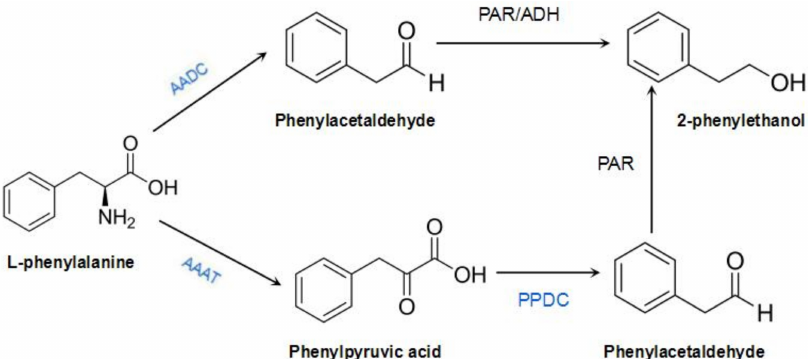
Figure 1. Biosynthesis pathway of 2-phenylethanol in Rosa species. PAR: phenylacetaldehyde reductase; ADH: alcohol